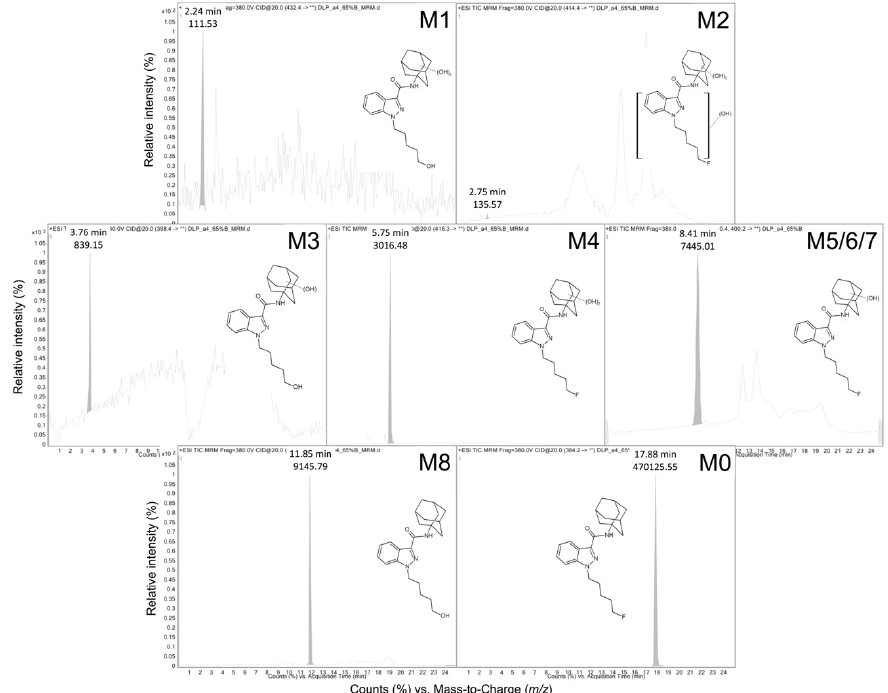
Figure A3. Extracted ion chromatograms from the total ion scan for all analytes. We resolved and analyzed metabolites from a 200 μM 5F-APINACA reaction to characterize their structures using an Agilent Technologic 1290 Infinity HPLC equipped with a 6490 Triple Quad MS. The above figure shows the extracted ion chromatograms from the total ion scan for all analytes. Subsequent MRM analysis of each analyte yielded fragmentation patterns indicated in Figure 2 and summarized in Table 1. M5 and M7 were visualized by MRM analysis but could not be visualized in the TIC due to poor signals. Signature ions are summarized in Table 1 and were used in the assignment of putative structures as described by previously